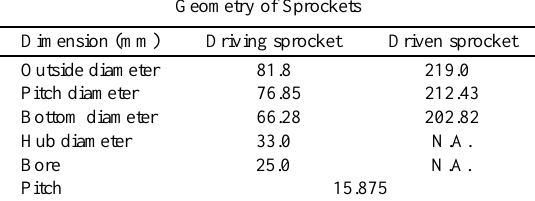
Table 1 Geometry of